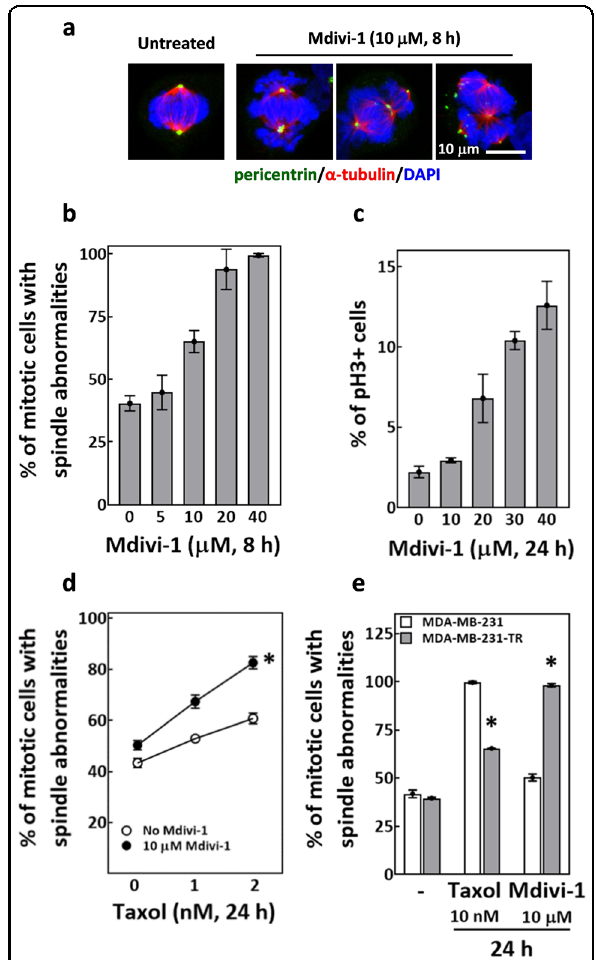
Fig. 2 Mdivi-1 disrupts mitotic spindle assembly, enhances taxol- induced spindle abnormalities, and induces spindle defects in taxol- resistant cells. a Representative image of untreated cells with a normal mitotic spindle and mdivi-1-treated cells with abnormal mitotic spindles. Cells were fi xed and immunostained for pericentrin (green), α -tubulin (red), and chromosomes (blue). b Mdivi-1 dose-dependently induced spindle abnormalities. MDA-MB-231 cells were treated for 8h with the indicated concentrations of mdivi-1, then subjected to analysis of mitotic spindles. Percentages of mitotic cells with spindle abnormalities are shown as mean±SD from at least three independent experiments. c Mdivi-1 induced mitotic arrest. Cells were treated with mdivi-1 as indicated and subjected to fl ow cytometry analysis for phospho-histone H3-positive (pH3 + ) cells. The mean±SD from three independent experiments is shown. d Mdivi-1 further enhanced the spindle abnormalities induced by taxol. Cells were treated either with taxol alone or in combination with mdivi-1 at the indicated concentration for 24h and then subjected to analysis of mitotic spindles. The mean±SD from at least three independent experiments is shown. * p <0.05 comparing 10 μ M mdivi-1- treated groups to no mdivi-1-treated groups by two-way ANOVA. e The taxol-resistant MDA-MB-231-TR cells remained sensitive to mdivi-1- induced spindle abnormalities. MDA-MB-231 and the MDA-MB-231-TR cells were treated as indicated for 24h and then subjected to analysis of mitotic spindles. Percentages of mitotic cells with spindle abnormalities are shown as mean±SD from three independent experiments. * p <0.05 comparing MDA-MB-231-TR to MDA-MB-231 by Student ’ s t